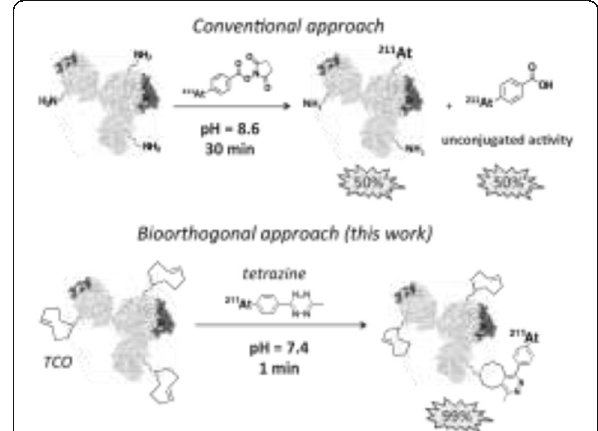
Fig. 1 (abstract OP32). Comparison between the “ NHS-lysine ” and “ bioorthogonal ” radiolabelling